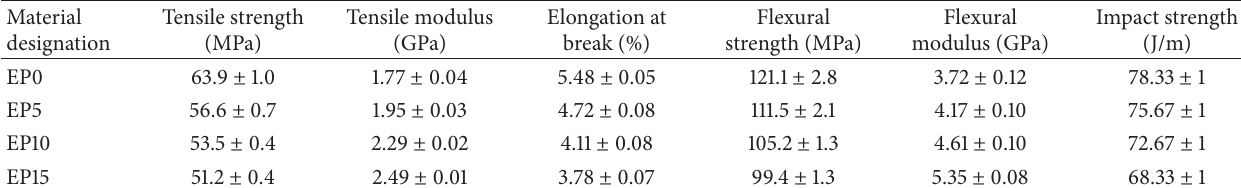
Table 3: Tensile, flexural, and impact properties of epoxy and epoxy/PTW